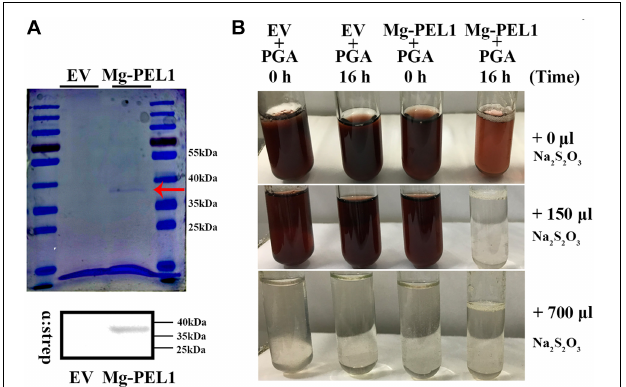
FIGURE 5 | Enzyme activity analysis of recombinant protein Mg-PEL1. (A) Expression and purification of recombinant Mg-PEL1: Strep. Mg-PEL1: Strep was purified by anti-Strep beads and separated by SDS PAGE with Coomassie brilliant blue staining (red arrow). Western blot was used to confirm the correct expression of recombinant protein Mg-PEL1: Strep in culture supernatants. (B) Enzyme activity of Mg-PEL1 was measured using a titrimetric stop reaction assay. Mg-PEL1 possesses enzyme activity to hydrolyze PGA into oligogalacturonic acids, which can bind to free iodine. The rest amount of free iodine was titrated against Na 2 S 2 O 3 using soluble starch as the indicator. The experiment was repeated three times. Similar results were obtained from three independent experiments. EV, empty vector; PGA, polygalacturonic acid.